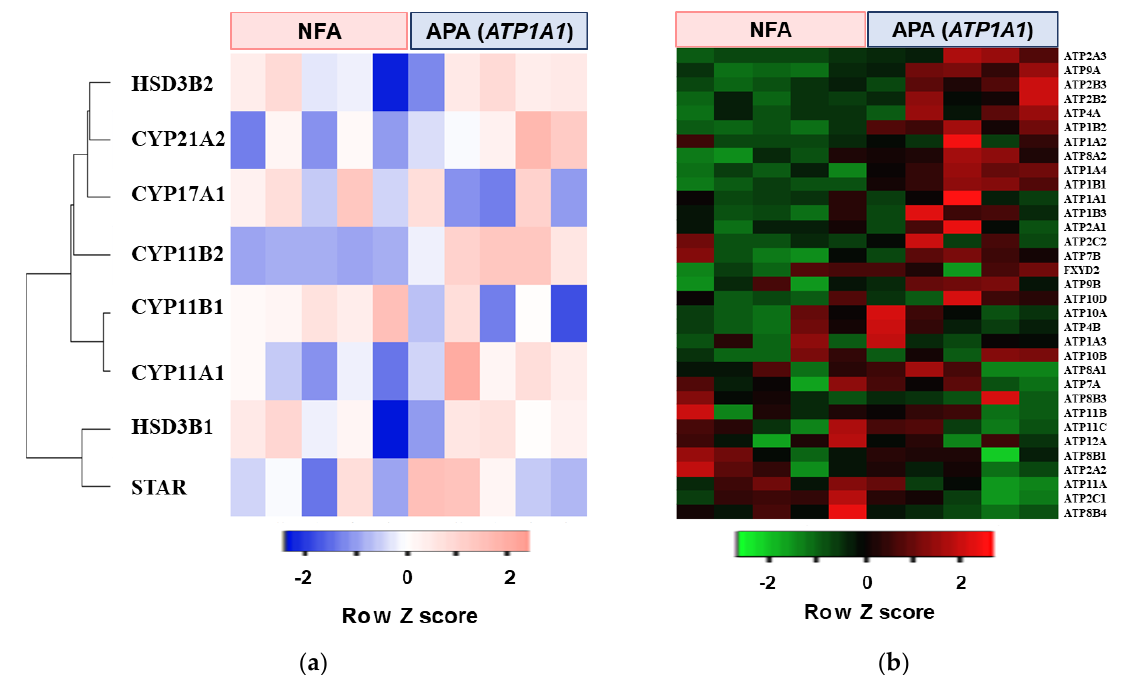
Figure 1. Heat map of concerns genes in five aldosterone–producing adenomas (APA) with an ATP1A1 mutation and five non–functioning adrenocortical adenomas (NFA). ( a ) Heat map of steroidogenic enzymes genes. ( b ) Heat map of genes related to P type ATPase function. Table 1. Pathway analysis using Gene Set Enrichment Analysis (GSEA) of genes expressed in five aldosterone-producing adenomas (APA) with an ATP1A1 mutation and five non-functioning adrenocortical adenomas (NFA).